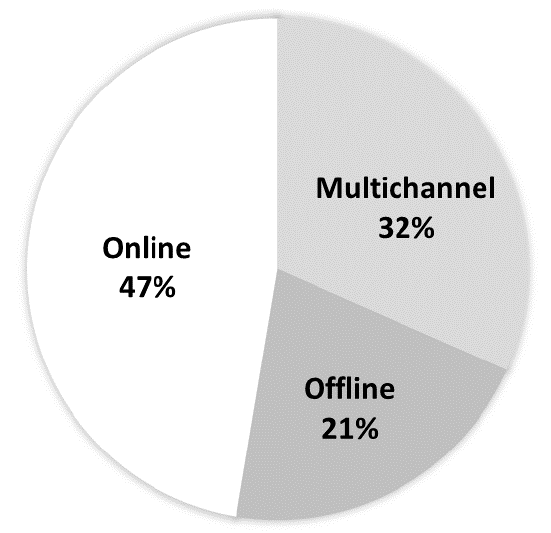
ff ering by free-market Spanish national electricity Figure 1. Channel offering by free-market Spanish national electricity retailers. Figure 1. Channel o